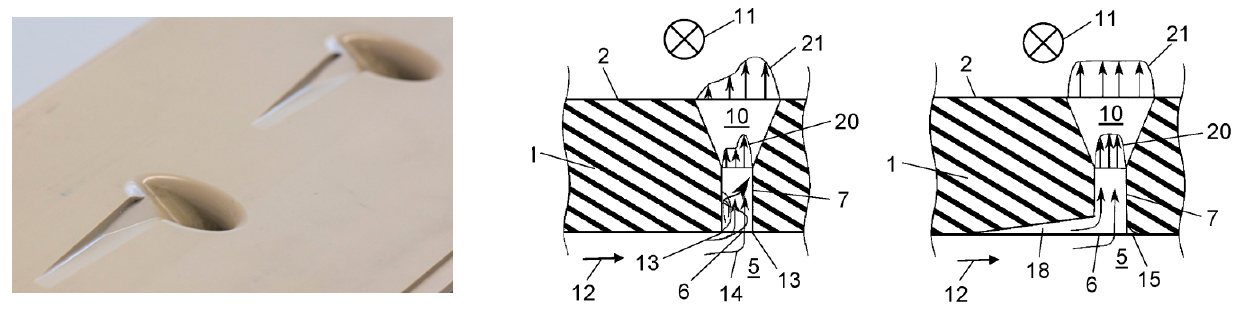
Figure 18. Aerodynamic film cooling hole inlets [110,111]. Rounded with NACA inlet to the film hole [112].